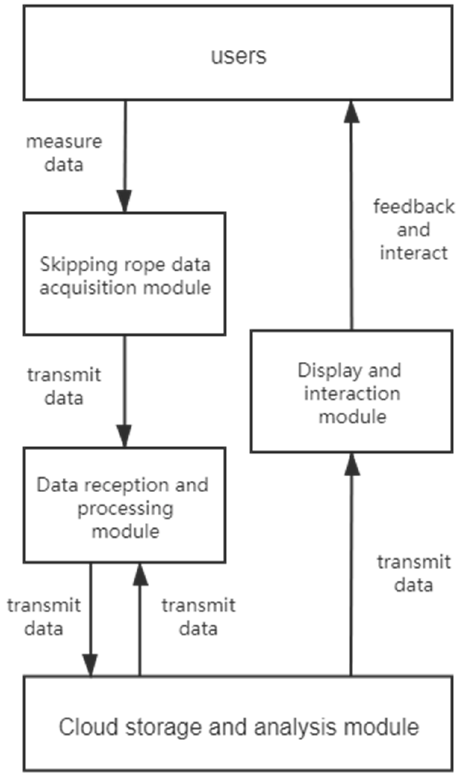
Figure 6. Acquisition-analysis-feedback framework. (1) Skipping rope data acquisition